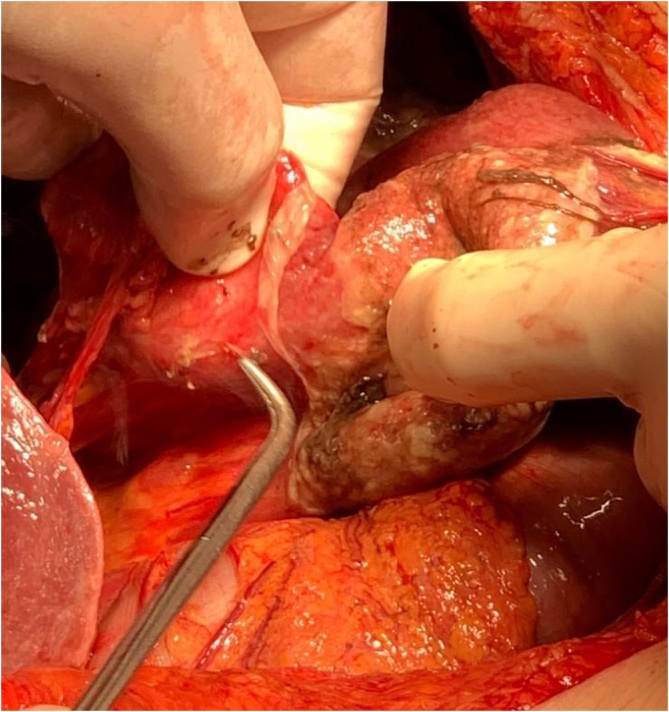
Intraoperative view.